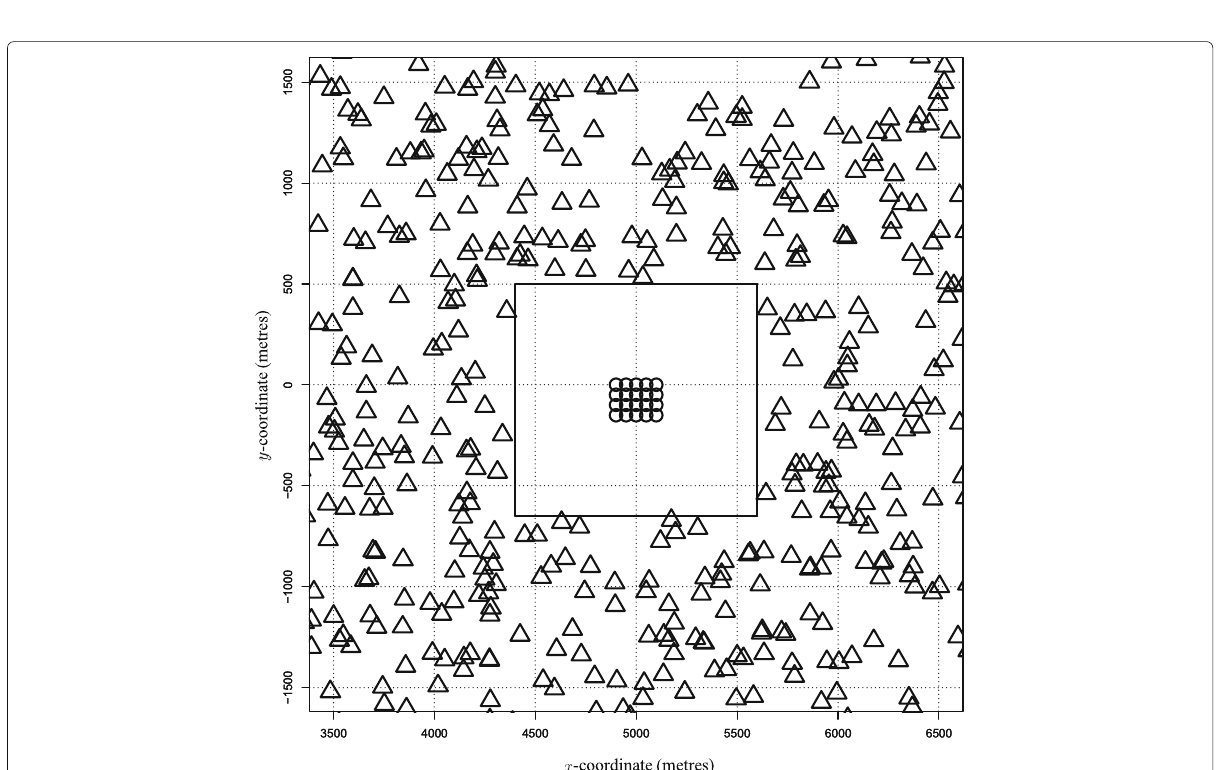
Fig. 3 Surveillance scenario. Shown are the sensor locations ( circles ) and randomly generated target event locations ( triangles ). Target events are not generated within 500 m of the sensor array